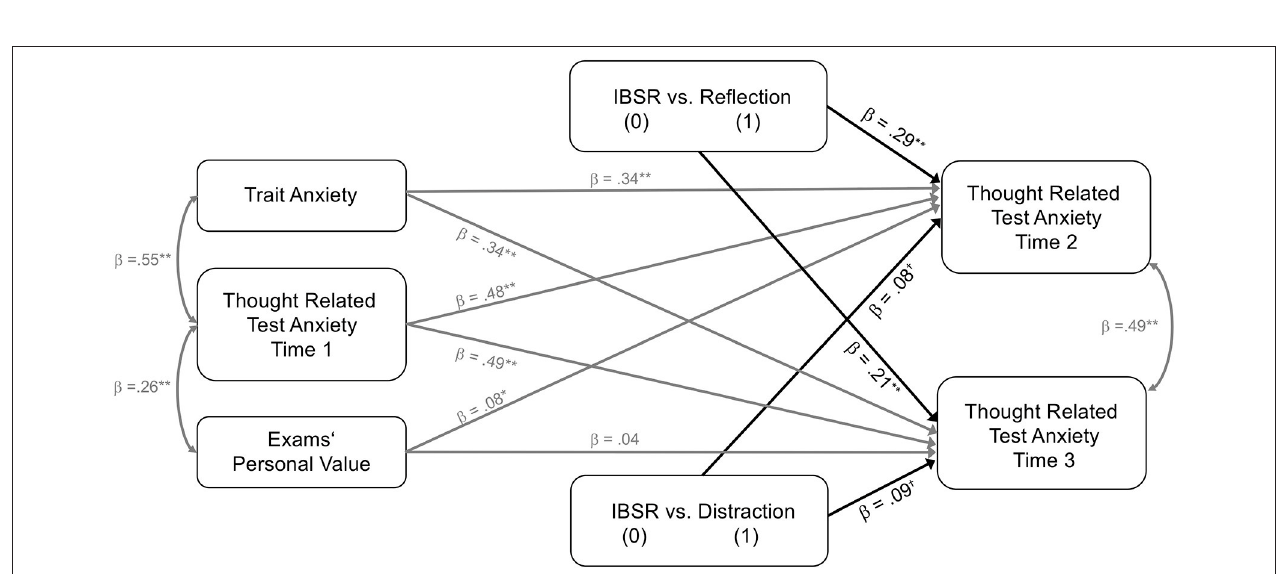
FIGURE 1 | Experimental intervention effects on targeted thought related test anxiety at times 2 and 3 while controlling for initial scores of thought related test anxiety, trait test anxiety, and exams’ personal value. IBSR (dummy coded 0) vs. distraction and reflection group (both dummy coded 1). All parameter estimates are standardized. N = 160. * p ≤ 0.05, ** p ≤ 0.01.